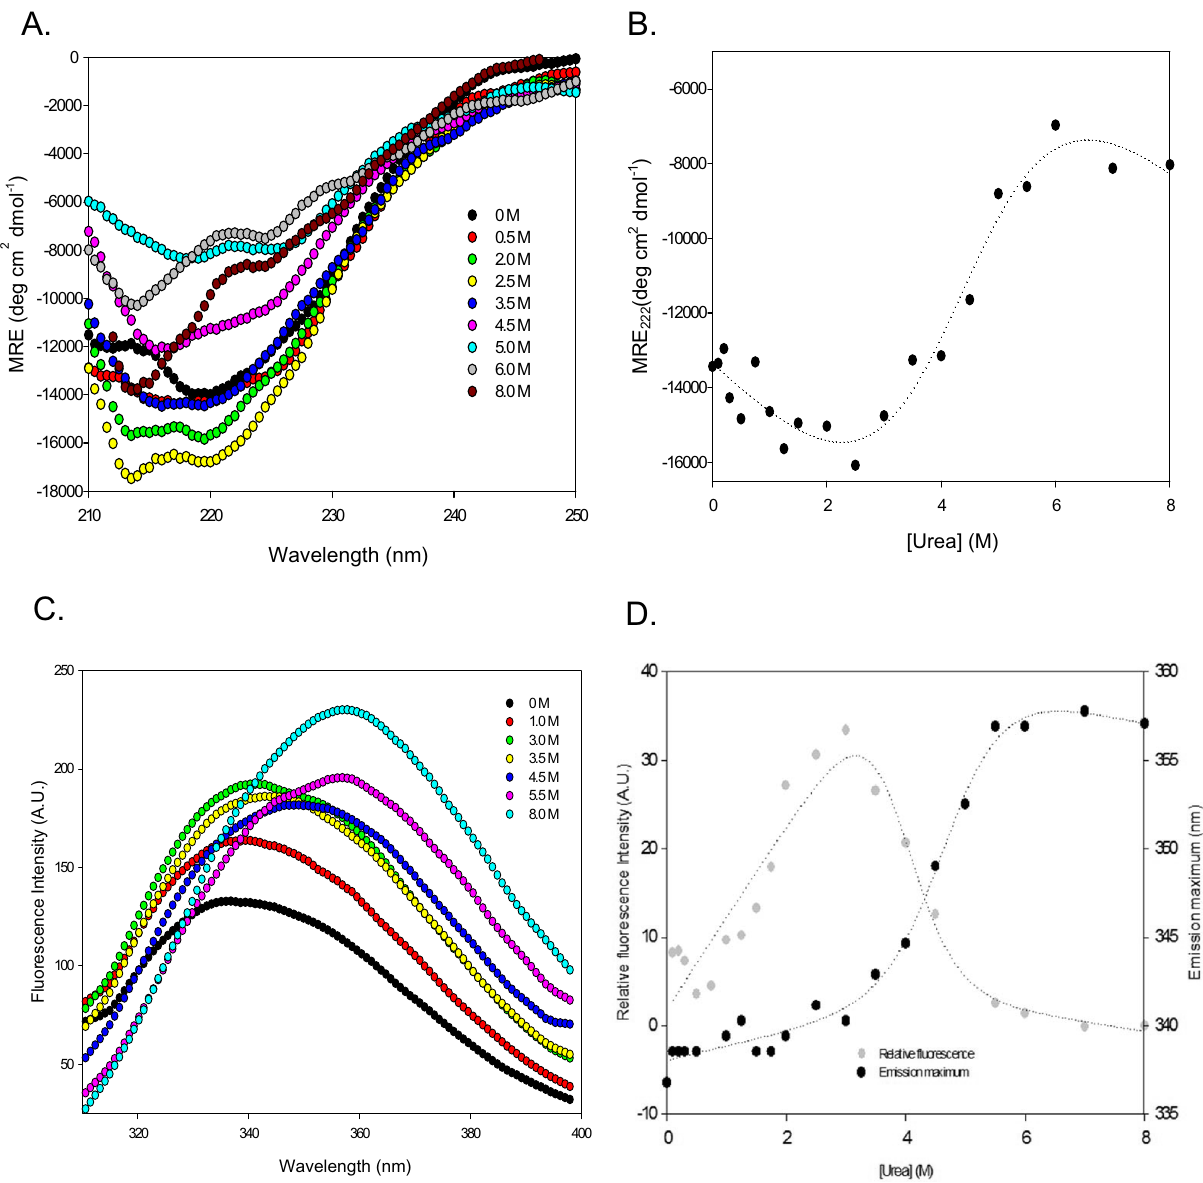
Figure 7. Urea-mediated equilibrium unfolding of AAR. Upper panel represents urea-mediated equilibrium unfolding probed by CD spectroscopy. ( A ) Graph shows far-UV CD spectra of AAR at different urea concentrations. Lower panel represents urea-mediated unfolding probed by intrinsic fluorescence spectroscopy. ( B ) Graph shows the urea-induced unfolding profile of AAR (3.5 µM) monitored by far-UV CD at 222 nm at different varying concentrations of urea. The intercept and slope of baselines, of the unfolding transition curve, were used for fitting of data in Eq. (6) (data analysis section). ( C ) Graph shows fluorescence emission spectra of AAR monitored from 310 to 400 nm when excited at 295 nm at different concentration of urea. ( D ) Graph represents the relative fluorescence intensity of AAR at 340 nm subjected to varying urea concentration. The secondary axis plot shows the change in the emission maximum (λ max ) at different concentrations of urea. The intercept and slope of baselines, of the unfolding transition curve, were used for fitting of data in Eq. (6) (data analysis section).